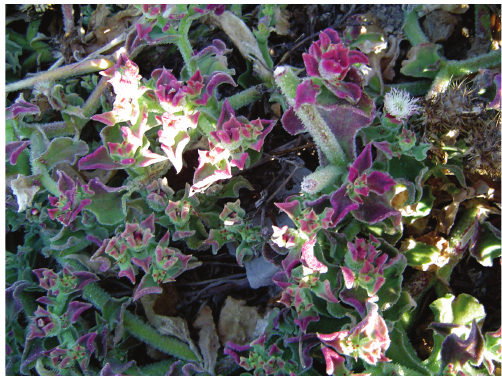
Figure 2: Mesembryanthemum crystallinum at June 2007 with floraison stage.